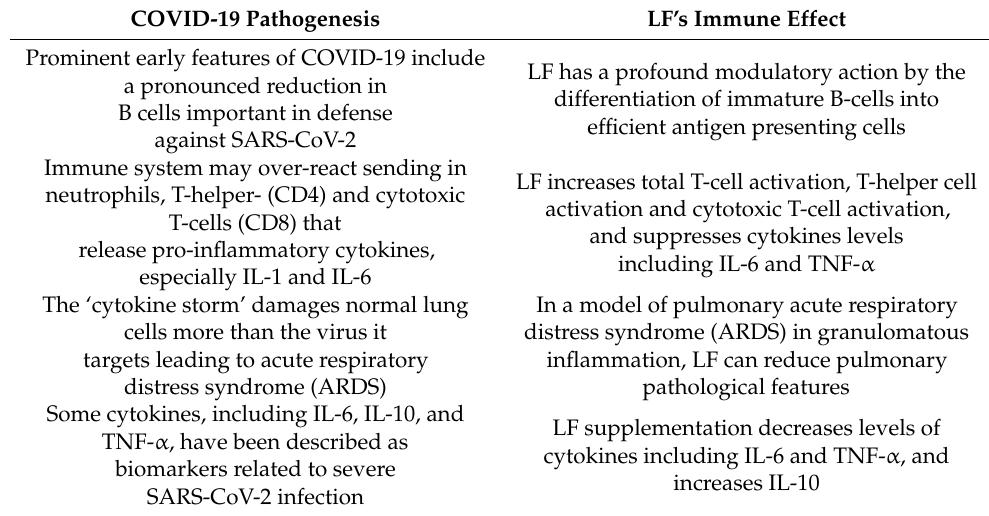
Table 4. Physiological effects as part of COVID-19 pathogenesis (left column) and counteracting immune effects of LF (right